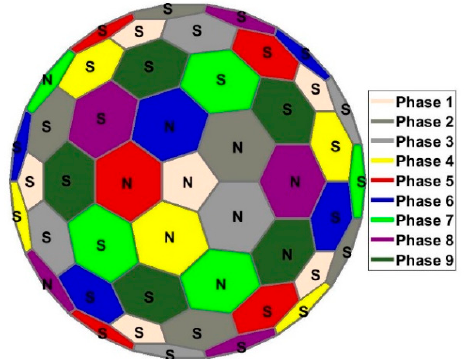
Figure 13. Stator phases and polarities. The phase groupings of Figure 12, together with Equation (9), produce these groupings and polarities. “N” and “S” correspond to north and south polarities, respectively, on the inner surface of the rotor bowl, as determined by the conventional current right-hand rule.